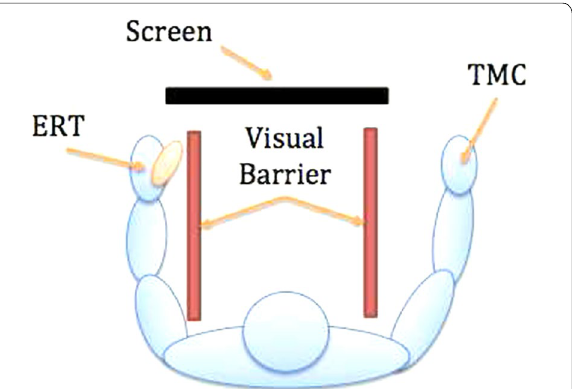
Fig. 6 First group condition, possible to see left hand